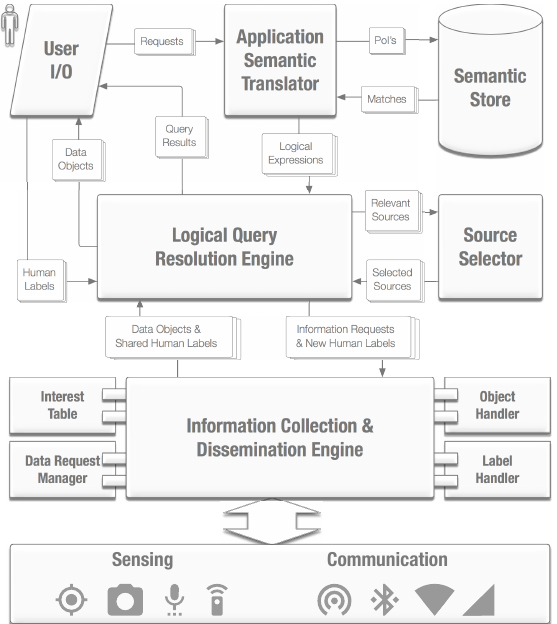
Figure 2. Athena’s architectural design, as well as how information propagates through different system